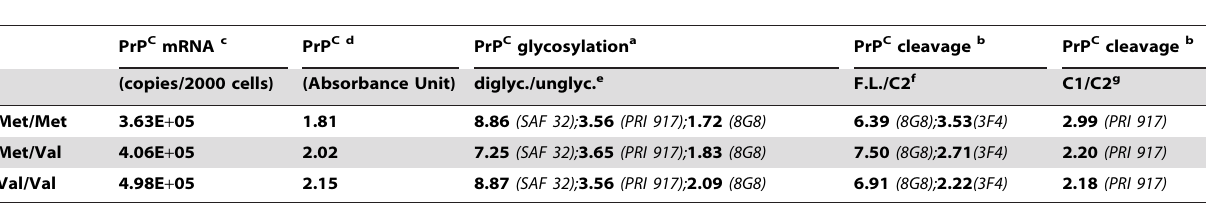
Table 2. PrP C expression and processing depending on the M129V